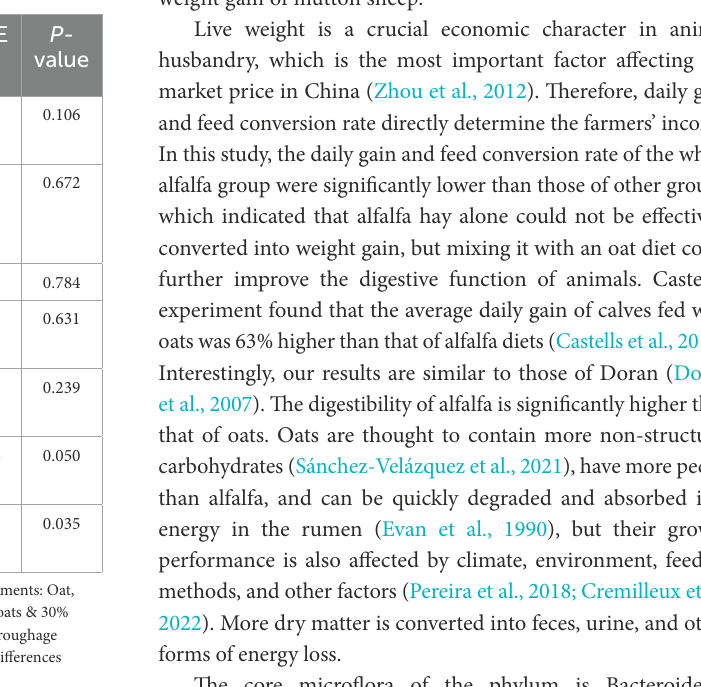
TABLE 4 Effects of oat and alfalfa on carcass traits of fattening goats and quality of